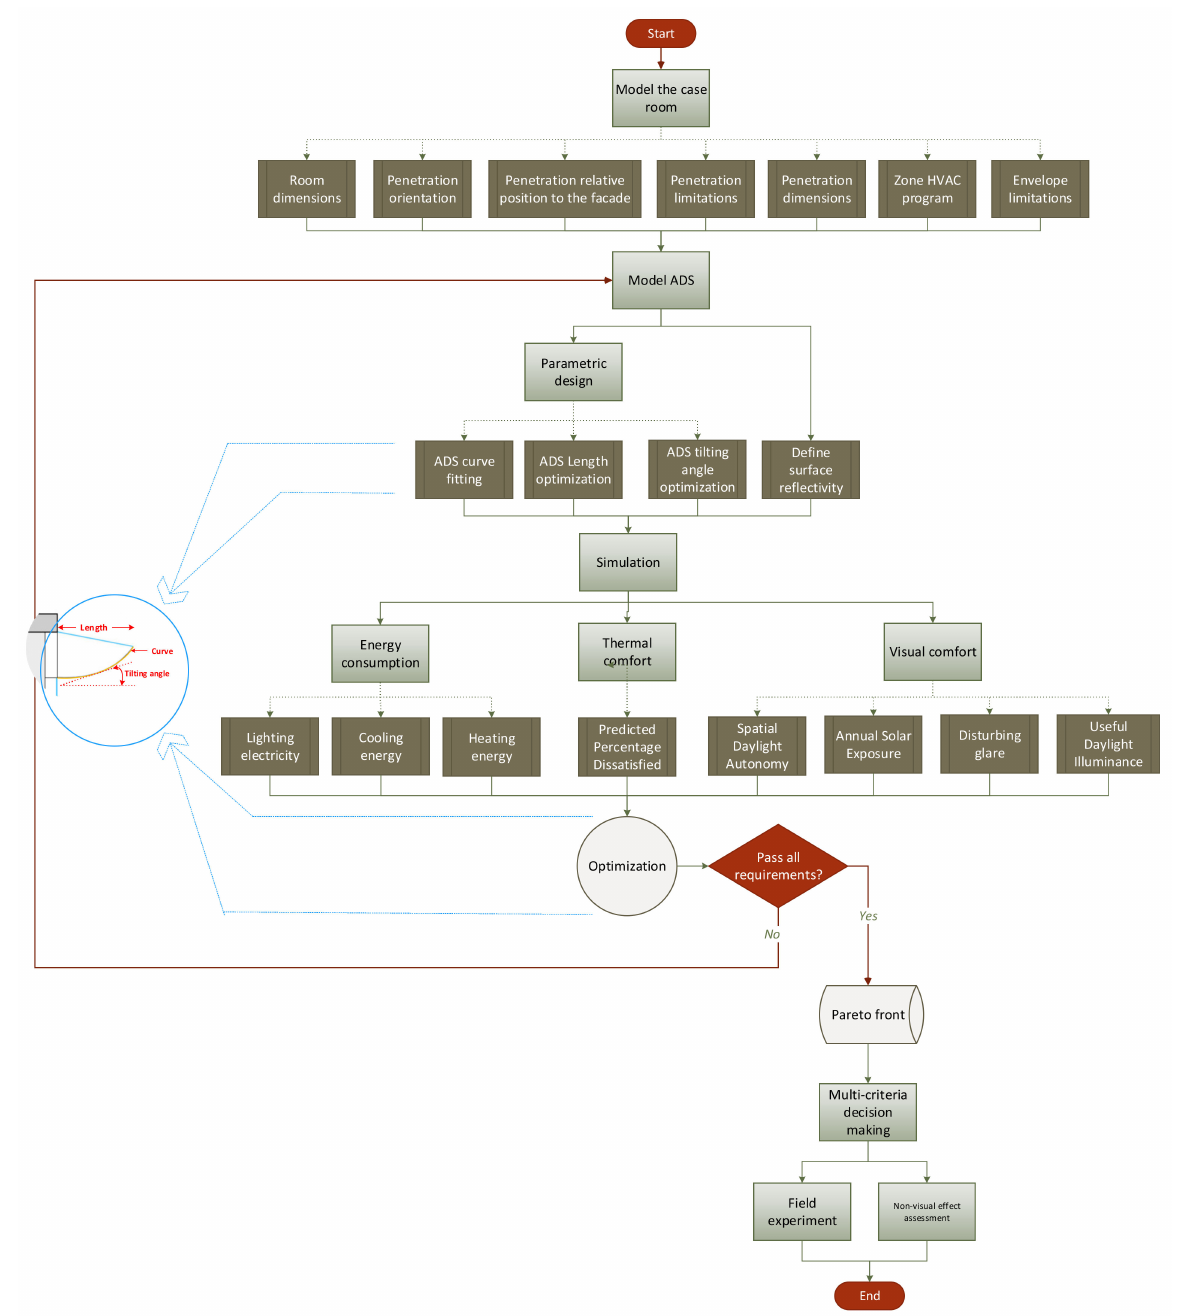
Figure 3. The block diagram for the current